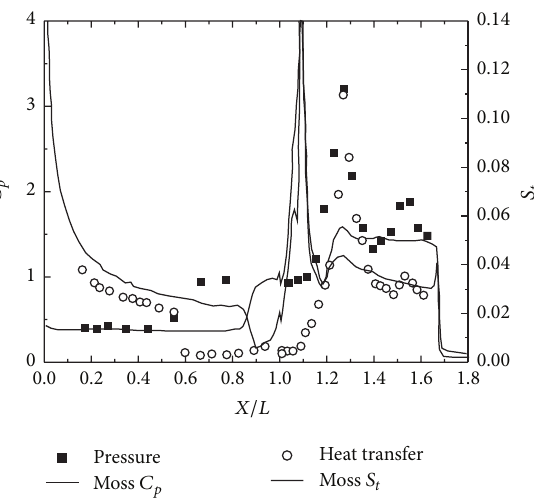
Figure 8: Boyd’s DSMC for Run number 35 [1, 15].